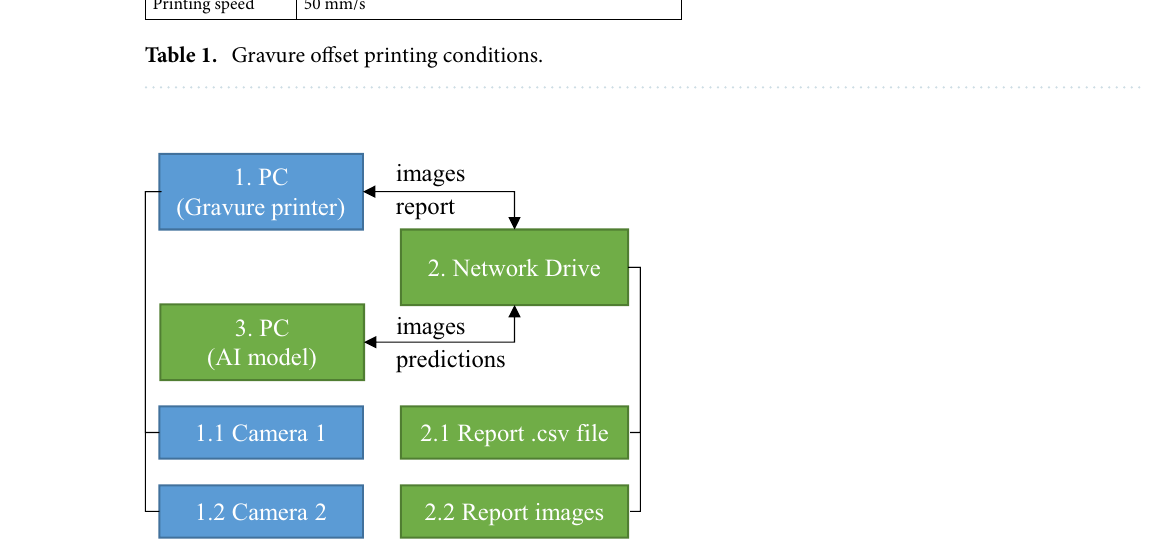
Figure 4. The scheme of AI model integration with the gravure offset system.